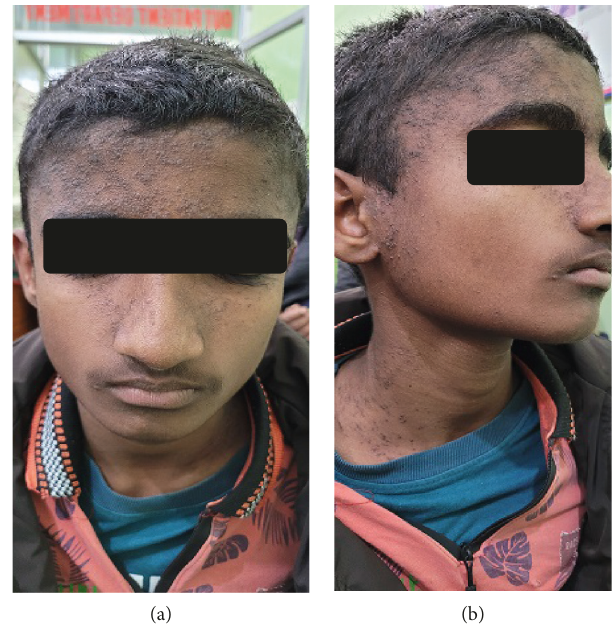
Figure 1: (a, b) Multiple flat-topped brownish verrucous plaques over the forehead, neck, and the periauricular area.